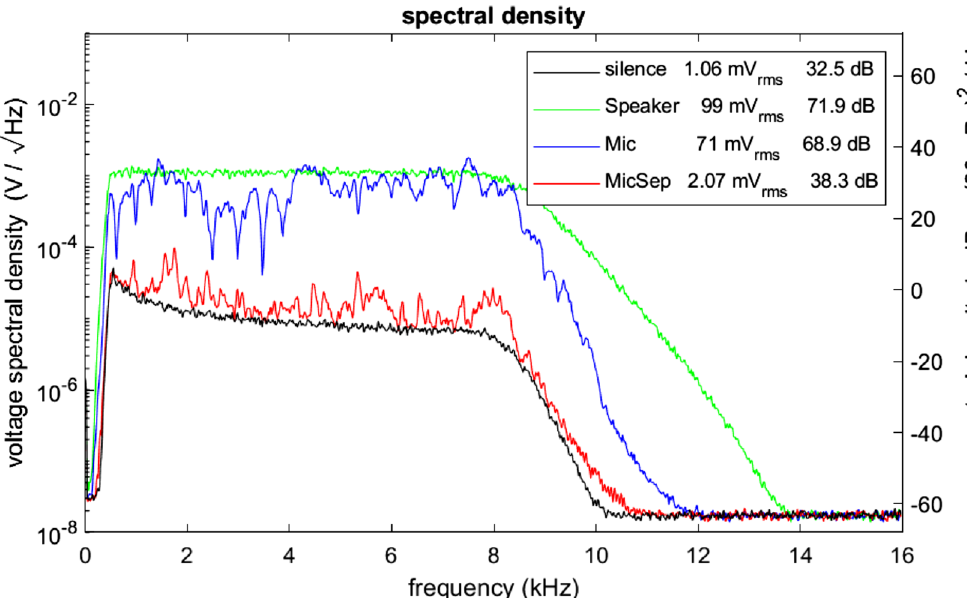
Figure 8. Power spectral densities of various input and output signals, demonstrating a roughly 30 dB echo attenuation. Green: white noise with a nominal 100 mV RMS amplitude played through the loudspeaker. Blue: raw microphone signal (Mic) with 3 dB lower amplitude. Red: the LMS filtered microphone signal (MicSep) with a roughly 30 dB reduced spectral density, close to the density of silence (black). The effect of the 500 Hz–8 kHz band-pass filter is visible by the cutoff. The legend indicates the overall RMS values and the corresponding sound pressure levels in dB re 20 µPa